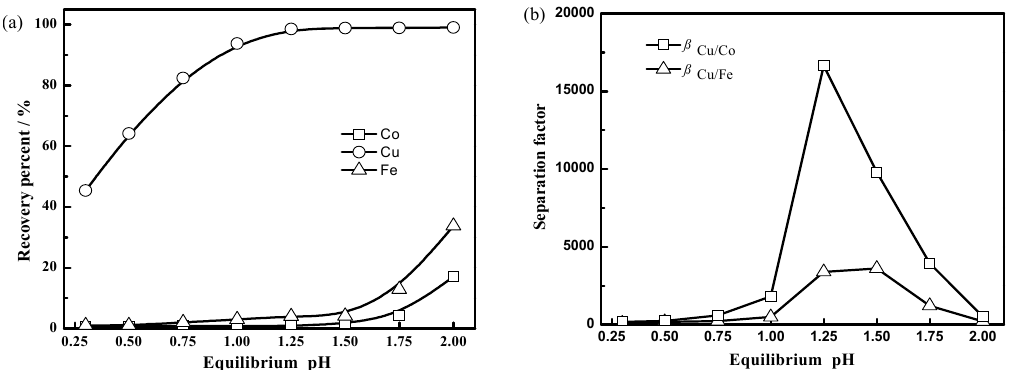
Figure 3. Effect of equilibrium pH on the recoveries of copper, cobalt, and iron ( a ) and separation factor ( b ) (A/O phase ratio = 1/1, LIX 984N concentration = 25% ( v / v ), contact time = 20 min, temperature = 25 °C).